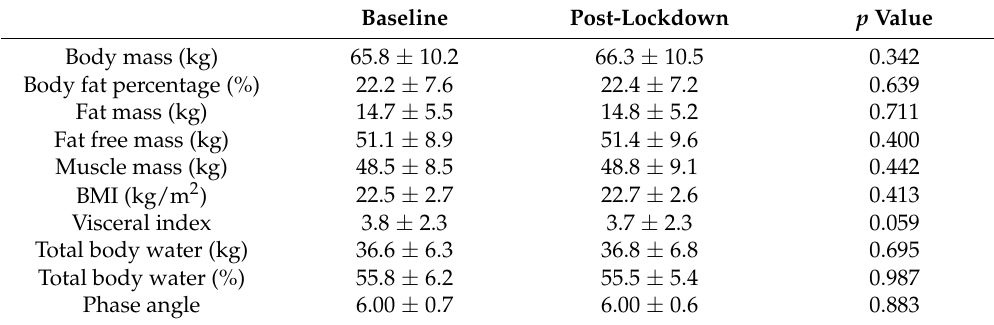
Table 5. Anthropometric Variables of Asymptomatic Subjects at the Baseline and